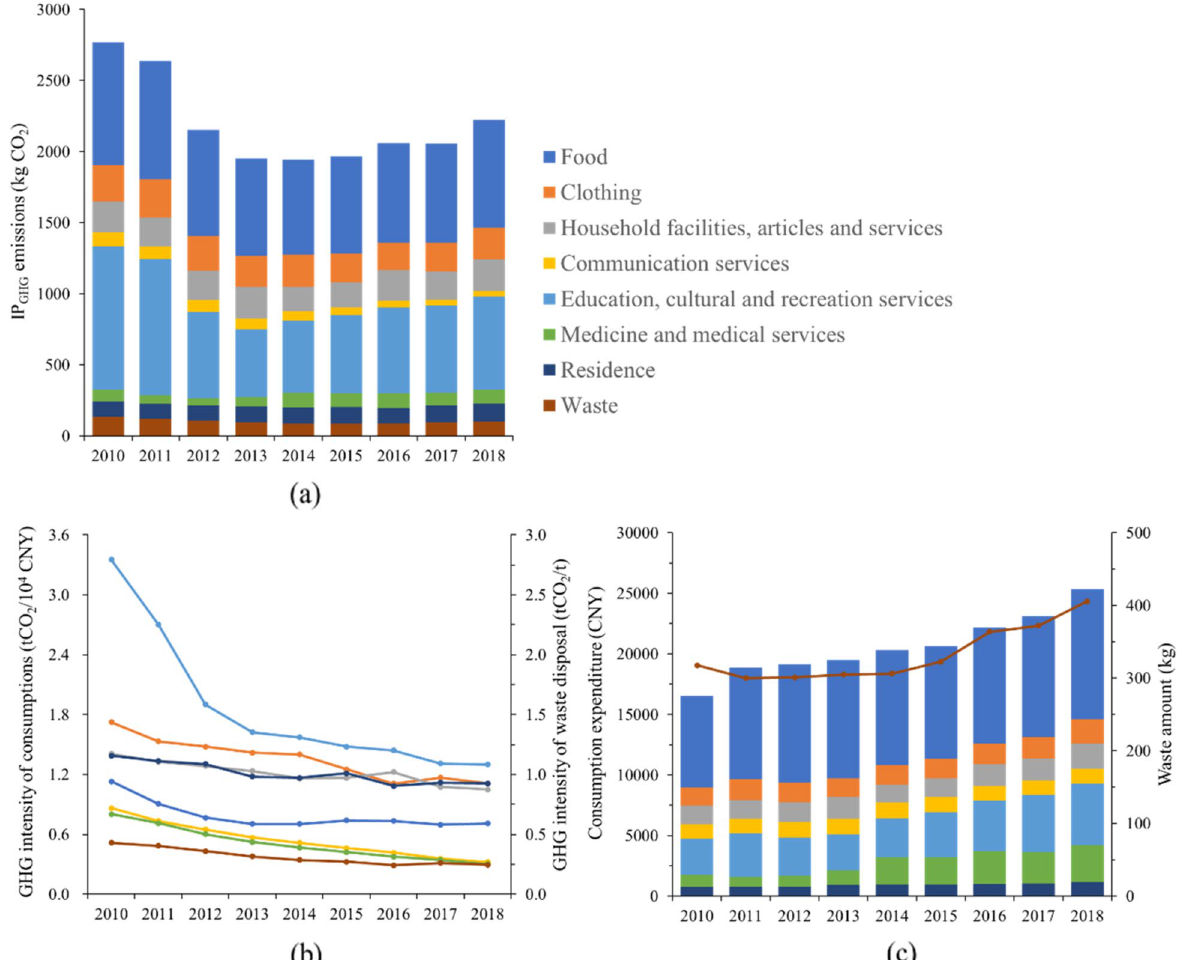
Fig. 4 a The variations of Shanghainese average IP GHG emissions (2010-2018); b : The GHG intensity of different sectors (2010-2018); c The consumption expenditure and waste amount per capita in Shanghai